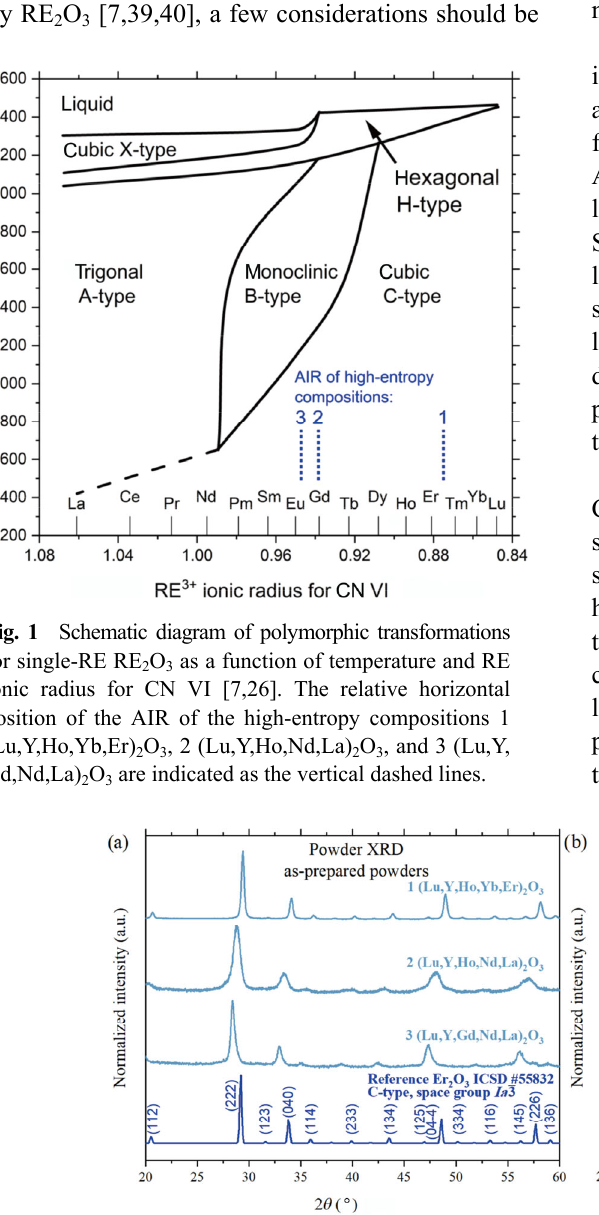
Fig. 2 Room-temperature powder XRD patterns: (a) As-prepared powders have a single C-type phase; a reference reflection pattern of Er 2 O 3 is shown for comparison. (b) Bead sample of composition 1 maintains the single C-type phase, while the beads of compositions 2 and 3 are a single B-type phase; a reference pattern of Sm 2 O 3 is shown for